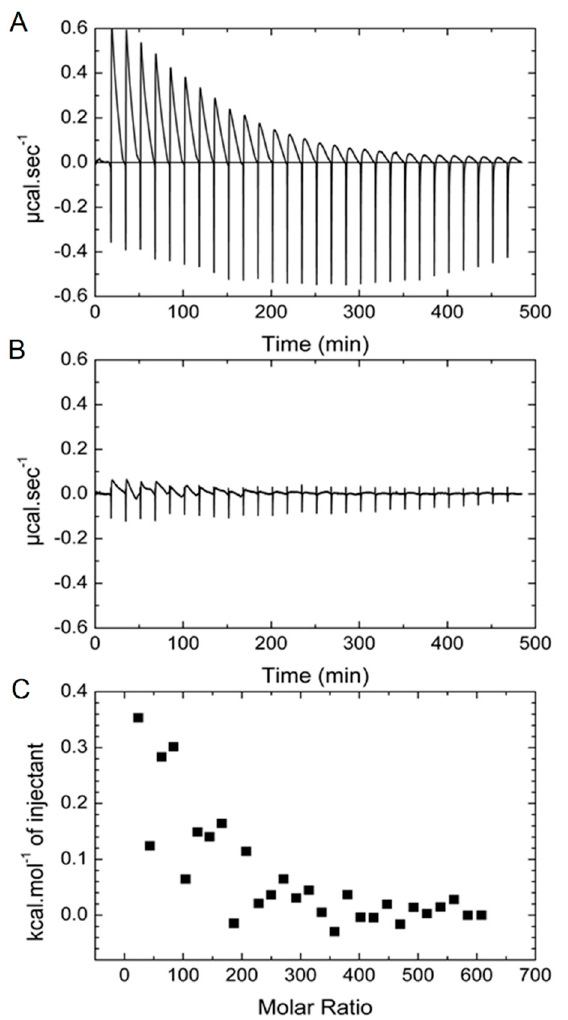
Figure 5. ( A ) Heat exchanges raw data of the addition of 10 µ L aliquots of AGuIX ® (7.5 × 10 − 3 M) in a HSA solution (3 × 10 − 6 M). ( B ) Heat exchanges obtained after subtraction of the control experiments (titration of AGuIX ® solution to bu ff er, bu ff er into HSA, and bu ff er into bu ff er). ( C ) Titration data calculated from the subtracted data. Each experiment was done at 20 °C.